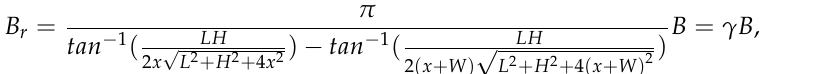
where L , H , W are the length, height, and width of magnet, in which W is in the magnetized direction. For this same kind of TMSB, α is fixed to 2.939. Thus, a (cid:48) = γ · a = 1.688, b (cid:48) = γ · b = 0.645 in Equation (3). The equation has been verified by Gauss meter and the deviation is less than